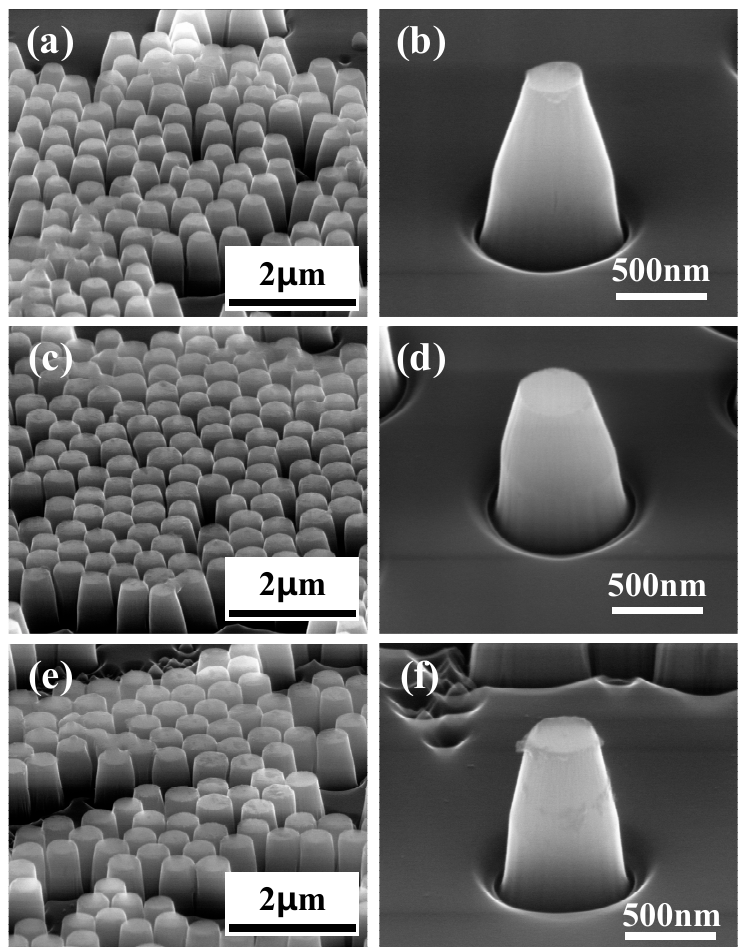
Figure 7. SEM images of cylinders on diamond surface acquired with 45° tilt angle of samples. ( b ), ( d ) and ( f ) are magnified single structure of ( a ), ( c ) and ( e ), respectively. ( a ), ( c ) and ( e ) were fabricated when Ar flow rate was 5, 10 and 15 sccm, respectively.